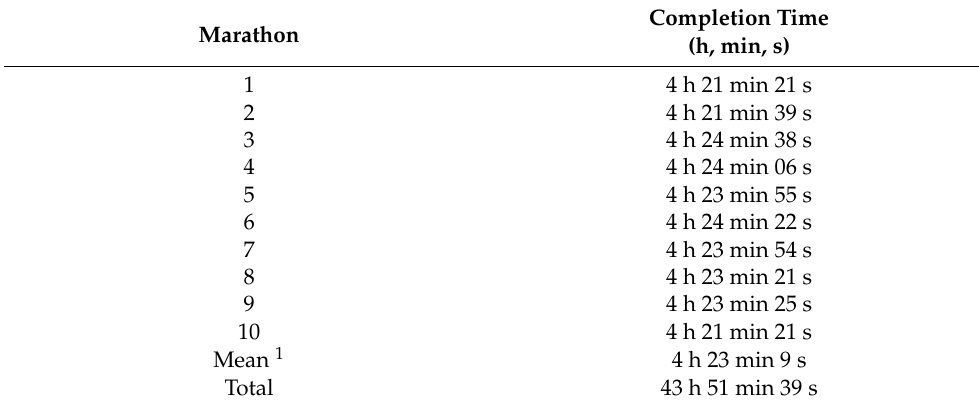
Figure 4. Percentage macronutrient contribution. Please note that mean carbohydrate contribution is 55% of total intake. Table 1. Completion times for all 10